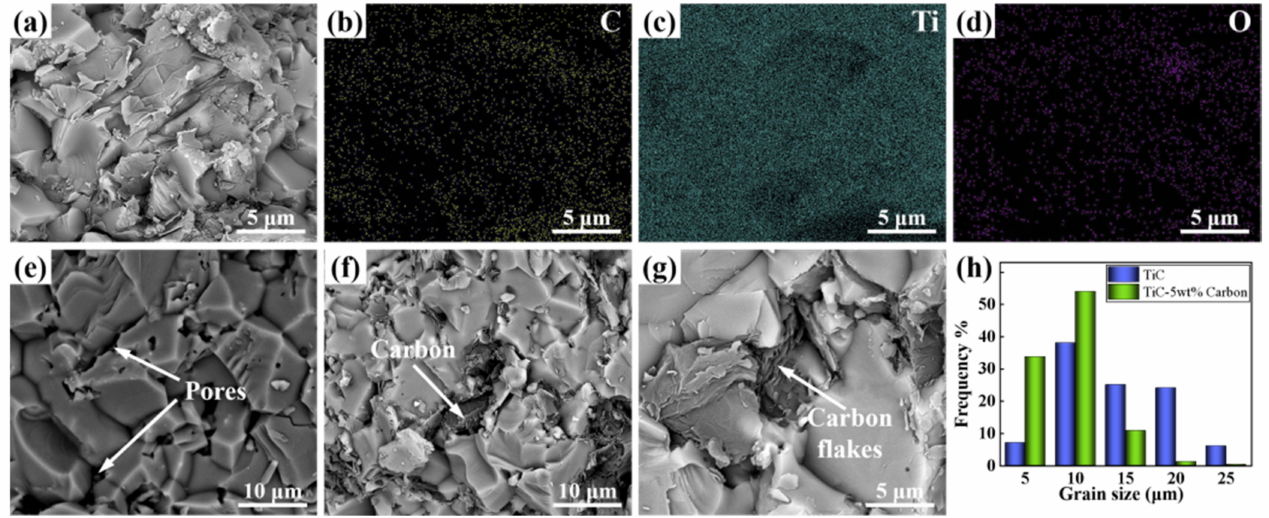
Figure 5. ( a – d ) SEM images of the fracture surface of TiC specimens and corresponding elemental maps; ( e – f ) FESEM images presenting the fracture surfaces of the monolithic TiC and TiC-5 wt.% carbon black samples; ( g ) High-magnification FESEM image presenting the fracture surface of the TiC-5 wt.% carbon black sample; ( h ) particle size distribution frequency of TiC and TiC-5 wt.% carbon black samples.